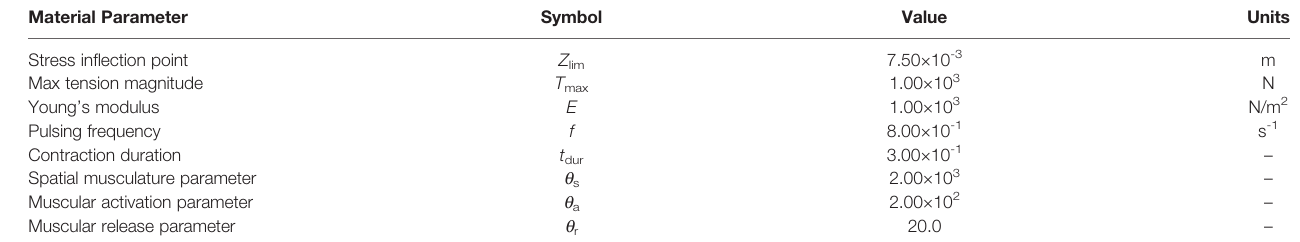
Muscular release